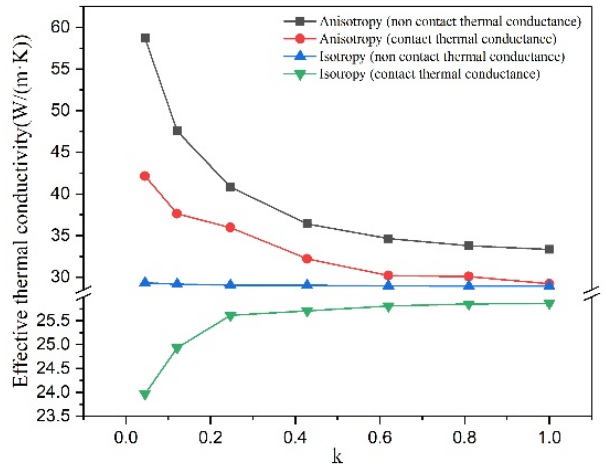
Figure 3. Effects of graphite anisotropy and ICTC on effective thermal conductivity of unit cell models containing simplified graphite models with different shape, v = 5%, λ m = 25 W/(m ·